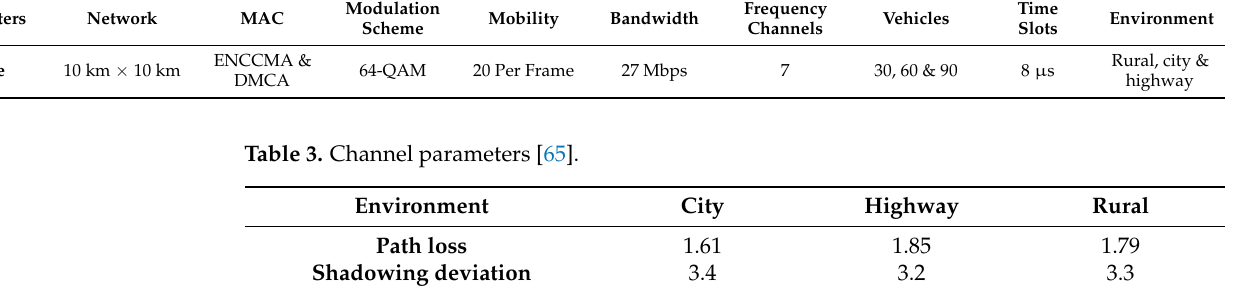
Figure 4. Throughput for the highway environment.